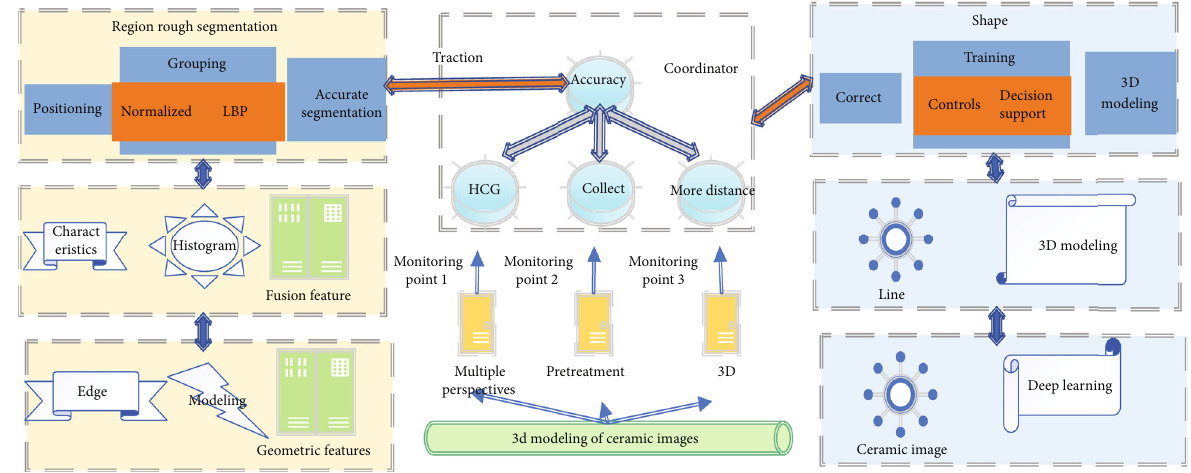
Figure 1: Overall scheme structure of ceramic image shape 3D image